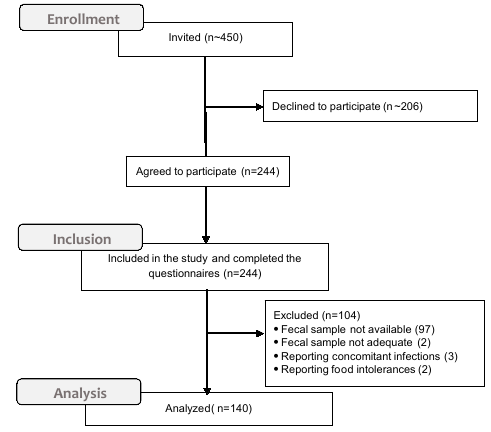
Figure 1. CONSORT diagram for the sample